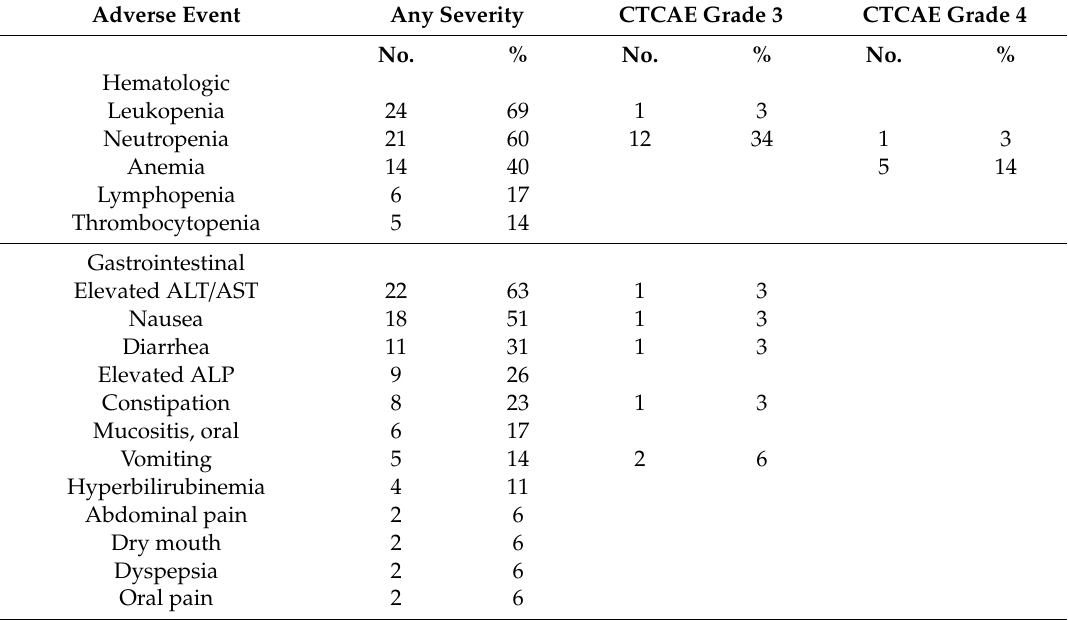
Table 3. Treatment-related adverse